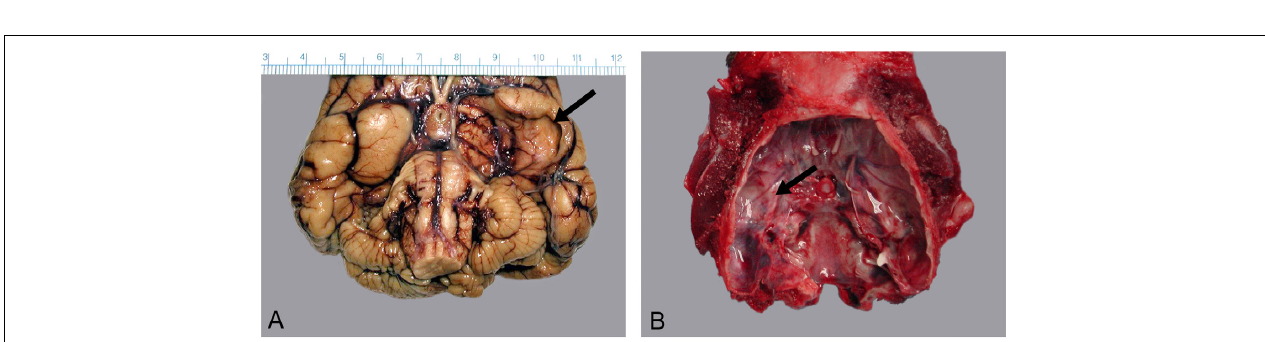
FIGURE 6 | Congenital porencephaly of the piriform lobe in a 9-month-old sea otter pup. (A) Ventral surface of the formalin fixed brain with the arrow indicating the collapsed cyst in the brain and (B) the deformation of the calvarium.